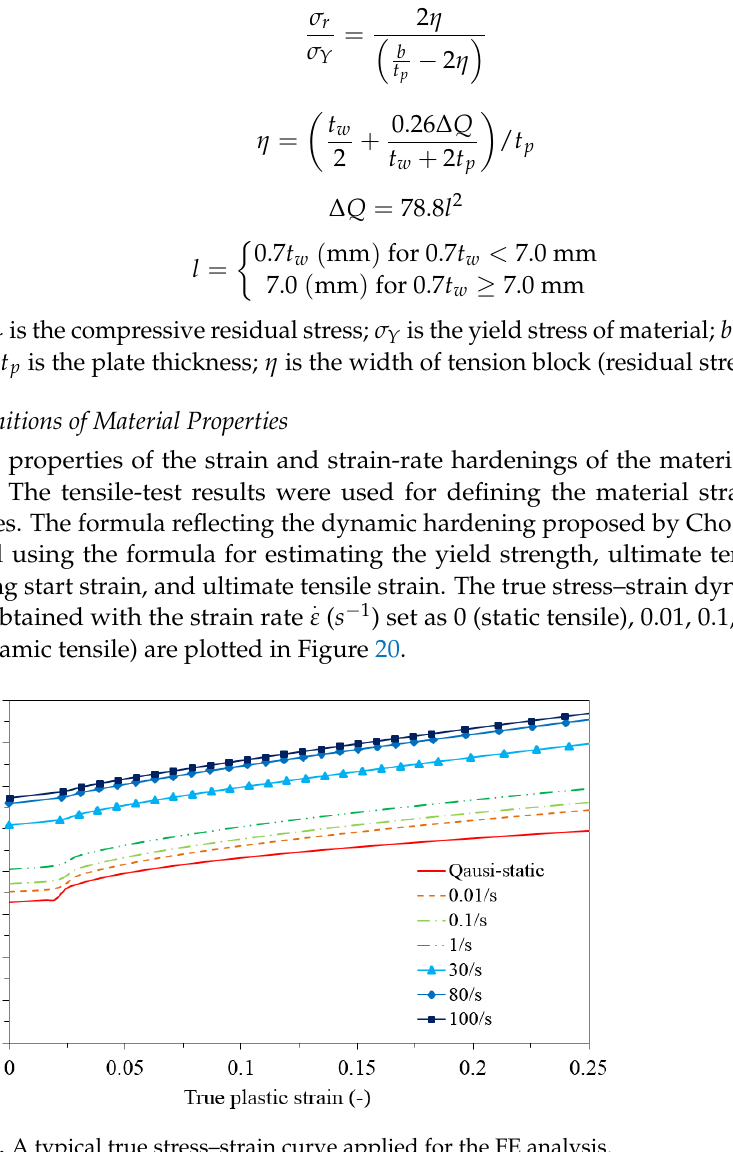
Figure 21. Numerical modeling and boundary condition for the collision simulation.